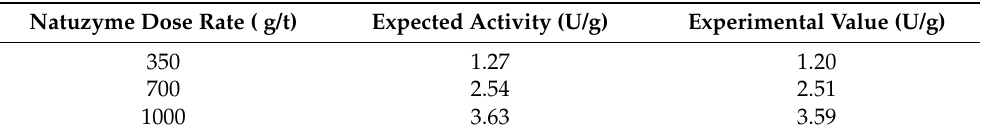
Table 4. Natuzyme expected vs. actual activity at different dose